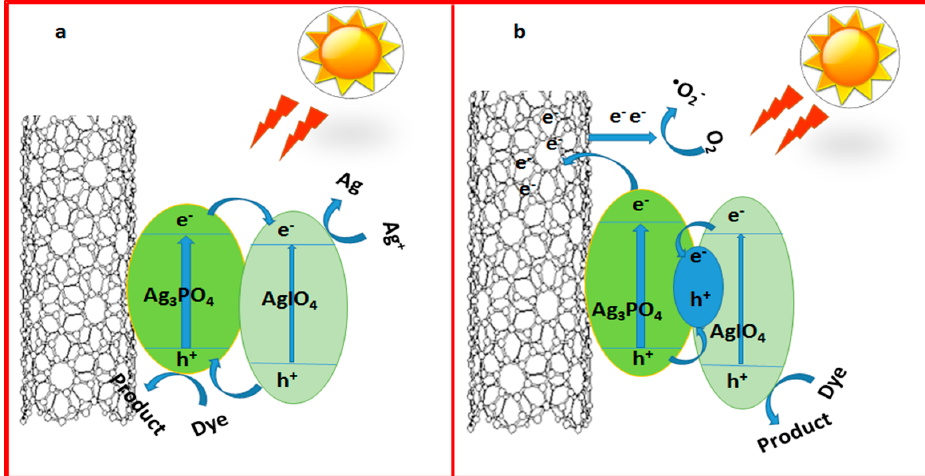
Figure 10. The proposed photocatalytic mechanism through which CNT-COO − /Ag 3 PO 4 @AgIO 4 composite degrades organic dyes based on ( a ) heterojunction energy band theory and ( b ) Z-scheme theory under visible light irradiation.